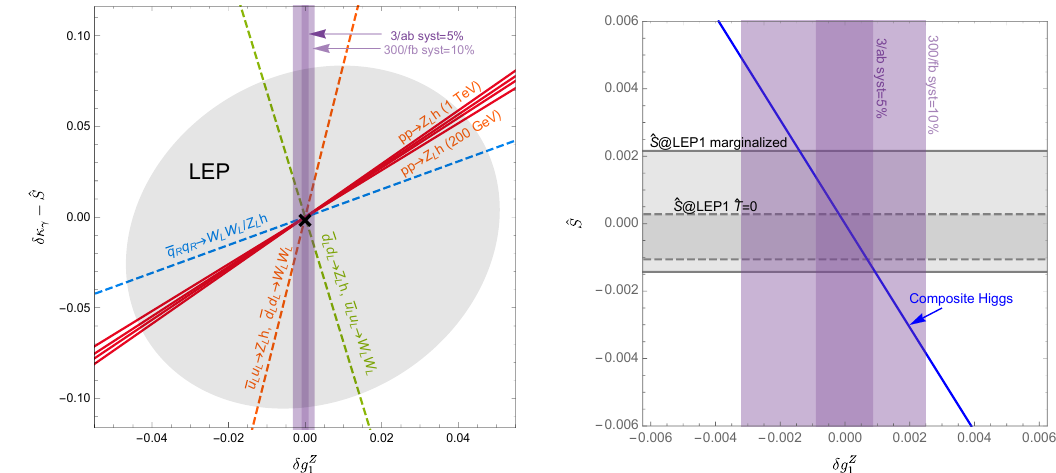
Figure 7 . Comparison of the bounds obtained from LEP with those from our analysis based on the WZ channel at the LHC. Left: universal theories with W; Y (cid:28) 1. Right: theories characterized by W; Y; (cid:14)(cid:20) (cid:13) ; (cid:21) (cid:13) (cid:28) 1. See main text for details.